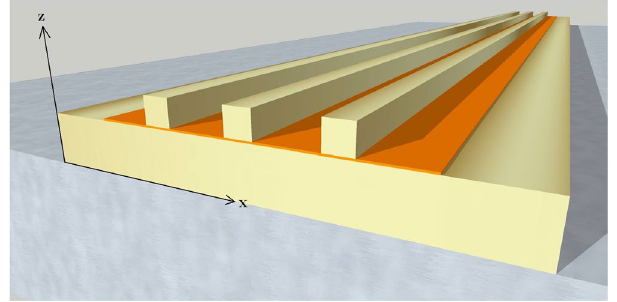
Figure 1. A 3D rendering of a selectively absorbing plasmonic metasurface based on gap-plasmon resonators: regularly spaced metallic nanorods coupled to a metallic substrate and separated from it by a nanometric dielectric